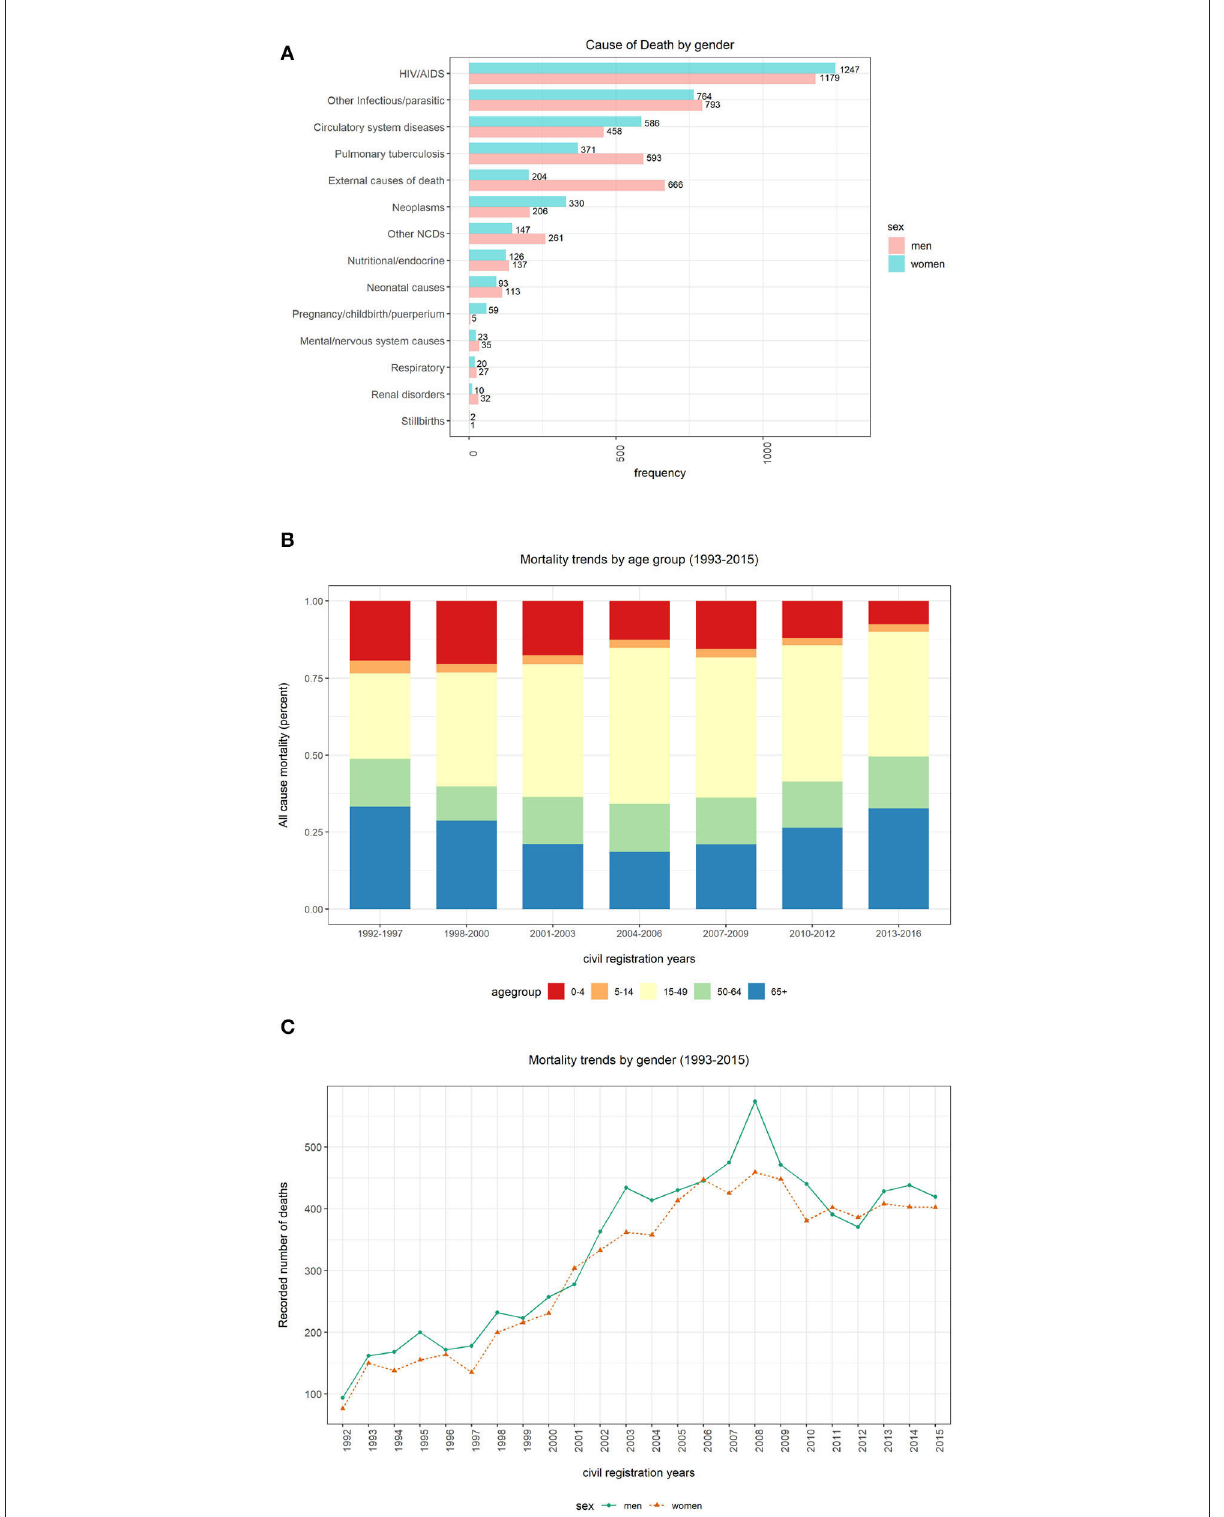
FIGURE4 Computer Coded Verbal Autopsy (CCVA) mortality trends based on age, population, and gender. (A) Cause of death by sex. (B) Percentage of deaths by age group. (C) Yearly mortality trends by